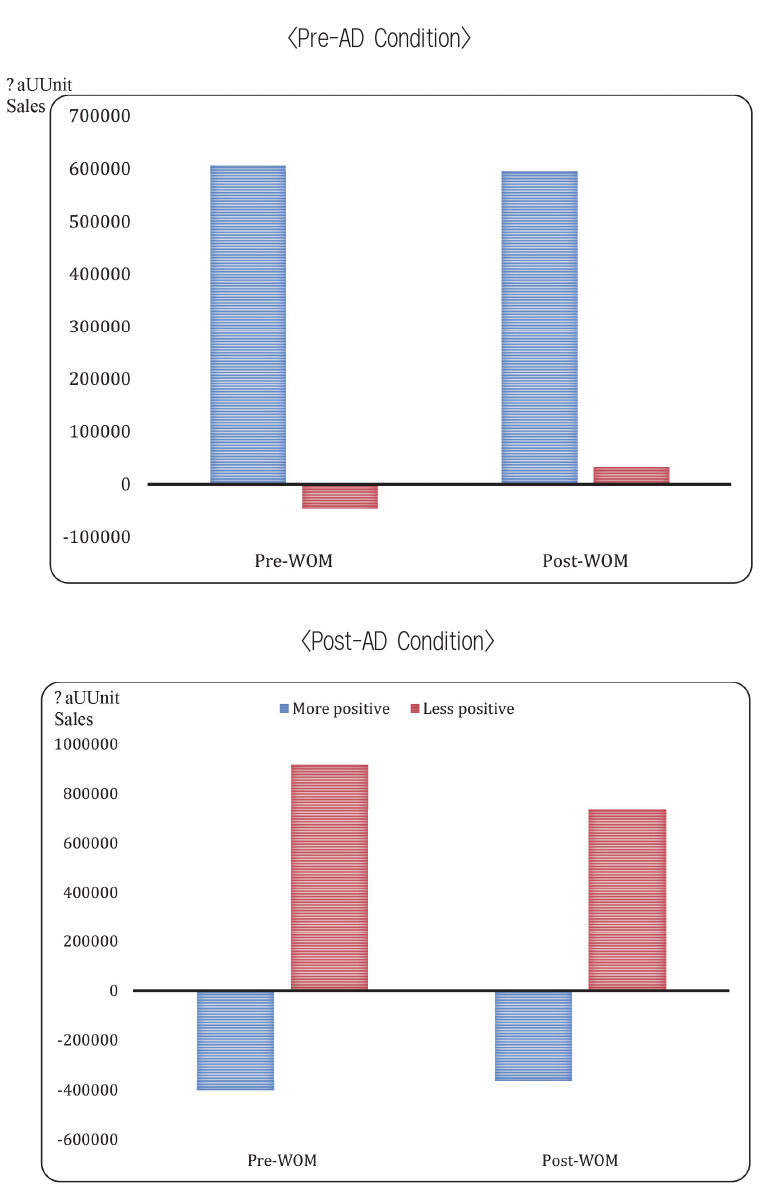
<Figure 3> The Moderating Role of Word-of-Mouth on the Demand Effect of